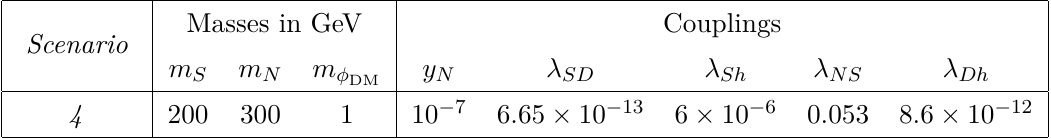
Table 5 . The choices of masses and couplings for Scenario-4